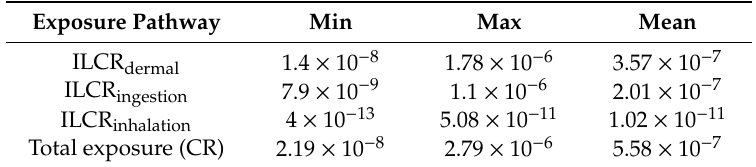
Table 5. Incremental lifetime cancer risk (ILCRs) and carcinogenic risk (CR) in di ff erent exposure pathways for